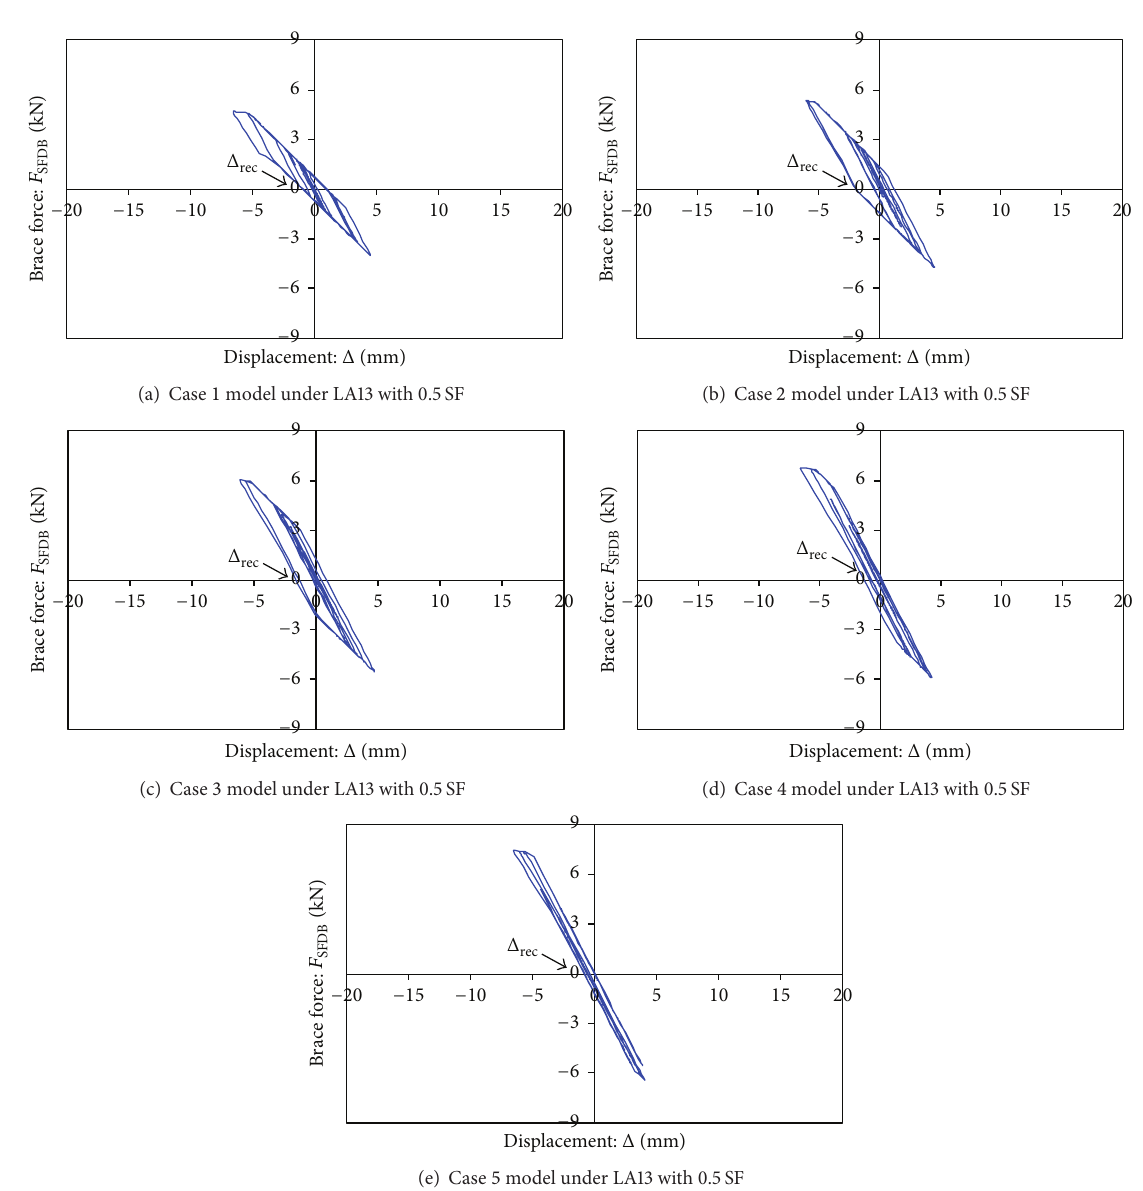
Figure 8: Force and displacement curves for individual SFDB models under the LA13 ground motion with 0.5 SF.